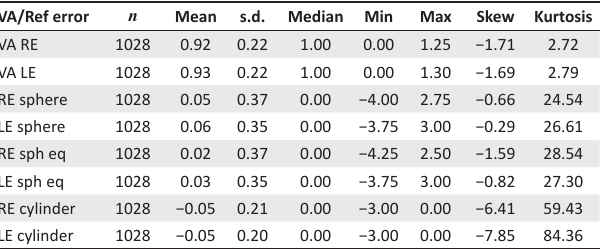
TABLE 1: Descriptive statistics for visual acuity and refractive errors. VA/Ref error n